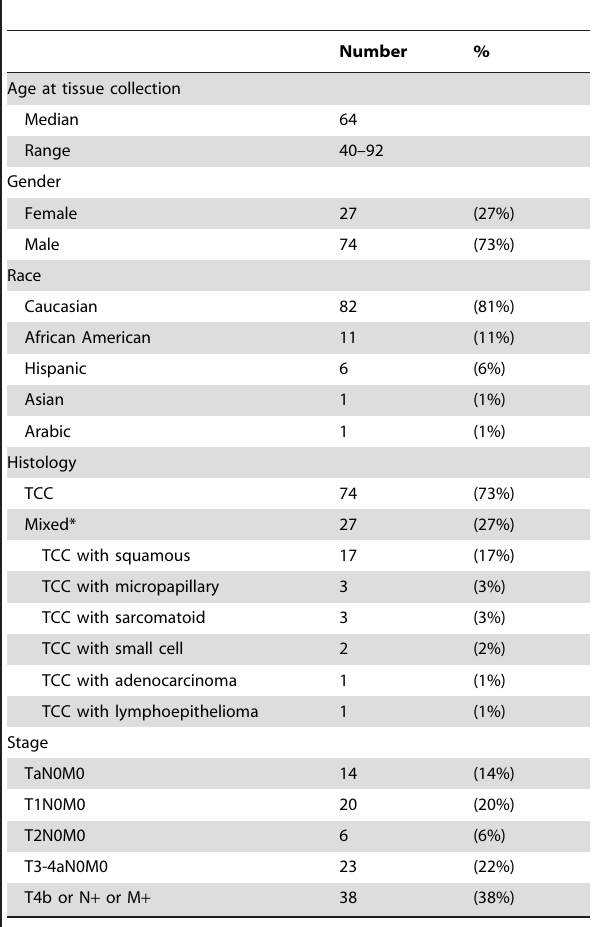
Table 1. Clinicopathologic characteristics of bladder tumor samples for RT-PCR, N=